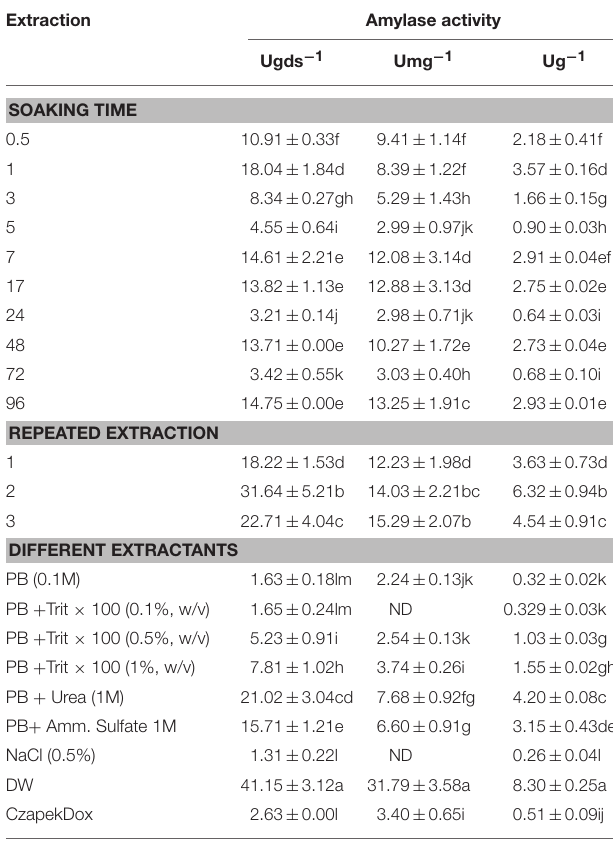
TABLE 5 | Effect of soaking time, repeated extraction and various extractants on amylase